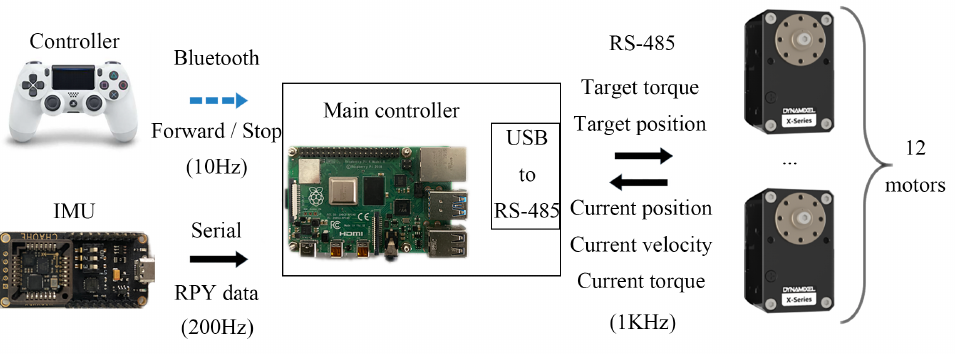
Figure 4. Hardware framework of wall-climbing robot